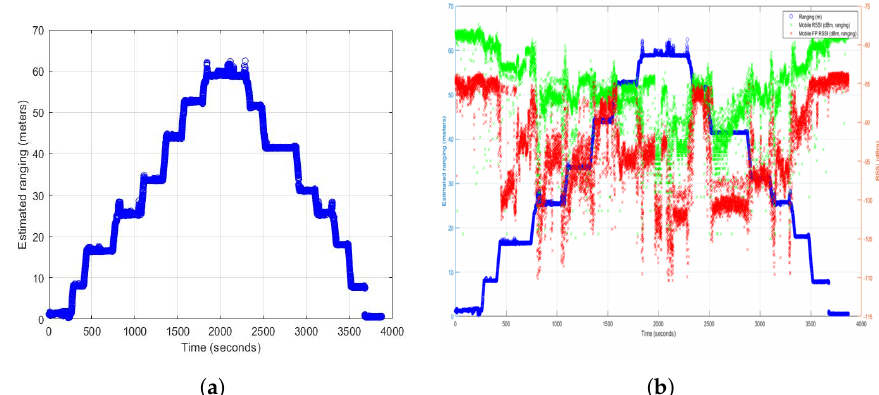
Figure 22. Estimated ranging and RSSI Test 2. ( a ) Estimated Ranging of the UWB ranging link. ( b ) Estimated ranging of the UWB ranging link and RSSI of the UWB communications link. Table 7. Results of the coverage tests in the ELICAN prototype.